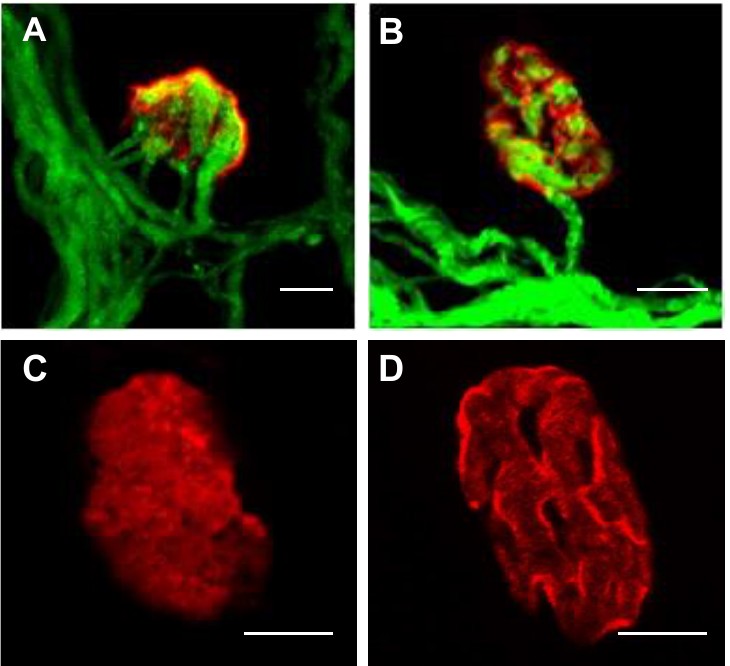
Figure 1. Confocal images of the postnatal innervation and morphological maturation of the postsynaptic nAChR clusters in P9 Thy1-YFP-16 normal mice. NMJ show the axons in green (mice express spectral variants of GFP, yellow-YFP) and the postsynaptic nicotinic acetylcholine receptor (nAChR) clusters stained in red with TRITC-α- BTX. ( A ), polyinnervated NMJ; ( B ), mature NMJ innervated by one axon; ( C ), a representative immature postsynaptic uniform cluster with no differentiated “holes”—endplate areas without receptors- and individualized gutters and in ( D ), a mature nAChR cluster. Scale bar: 10 μm.